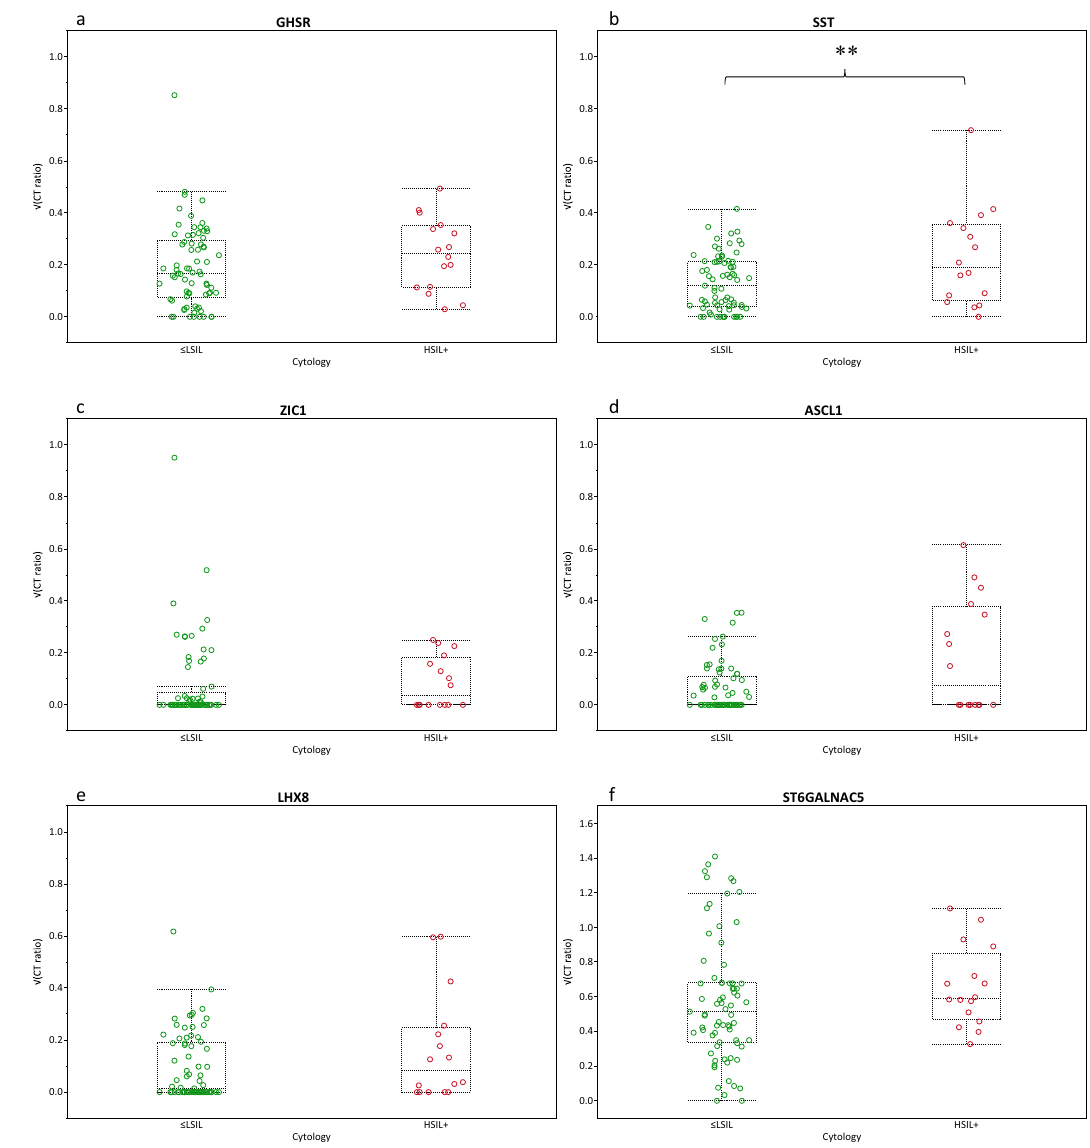
Figure 2. Difference in methylation ratios (square root transformed; y-axis) for normal/low-grade and high-grade cervical disease according to cytology outcome (HSIL +; x-axis); ≤ LSIL (green circles, n = 73) and HSIL + (red circles, n = 16). Box-plots indicate median methylation levels of ( a ) GHSR , ( b ) SST , ( c ) ZIC1 , ( d ) ASCL1 , ( e ) LHX8 , and ( f ) ST6GALNAC5 and according interquartile ranges (25th and 75th percentile). P-values (Mann Whitney U-test) indicated by a double asterisk mean that the null hypothesis (H0) is rejected (p ≤ 0.05) and that the median square root transformed methylation marker ratios between normal/low-grade and high- grade cervical disease are not equal. No trends were observed (0.05 < p ≤